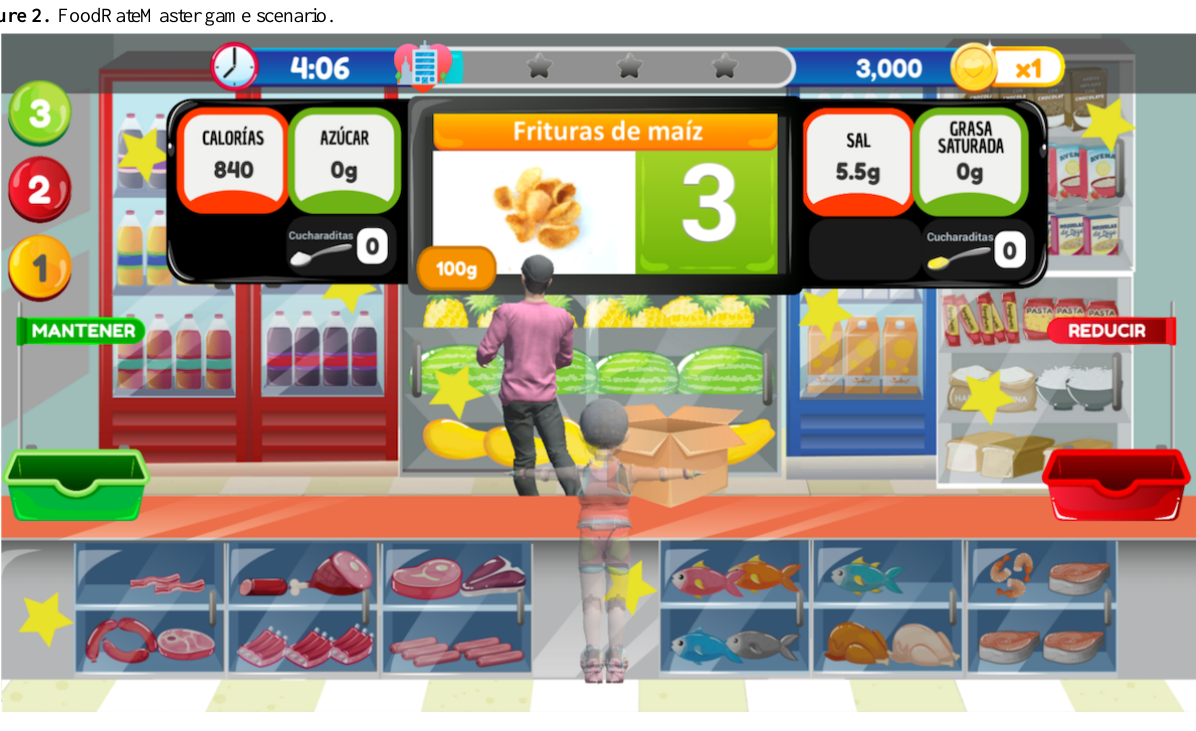
Figure 2. FoodRateMaster game